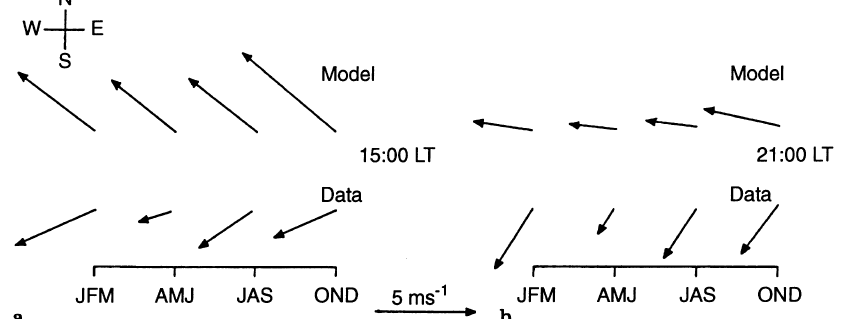
Fig. 12a,b. Simulated and observed three-month averages of the horizontal wind-vector for: a 15:00 LT and b 21:00 LT. The model values refer to the simulated sea-breeze (at level of 990 hPa) at a gridpoint situated inland 10 km from both the SN and EW coastlines